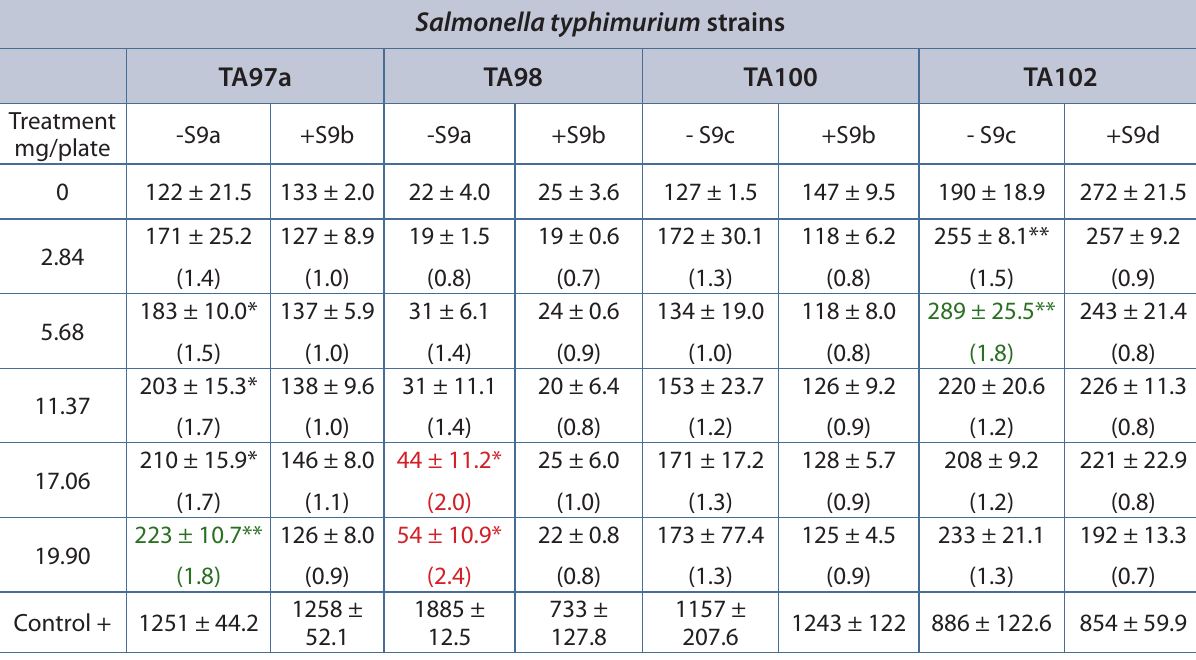
Table 1. Ames test ( Salmonella typhimurium ) for mutagenic activity (mean number of revertants/plate ± SD) of the bacterial strains TA97a, TA98, TA100 and TA102 exposed to Plathymenia reticulata hydroalcoholic extract, at various concentrations, with (+) and without ( - ) metabolic activation (S9) Salmonella typhimurium strains TA97a TA98 TA100 TA102 Treatment